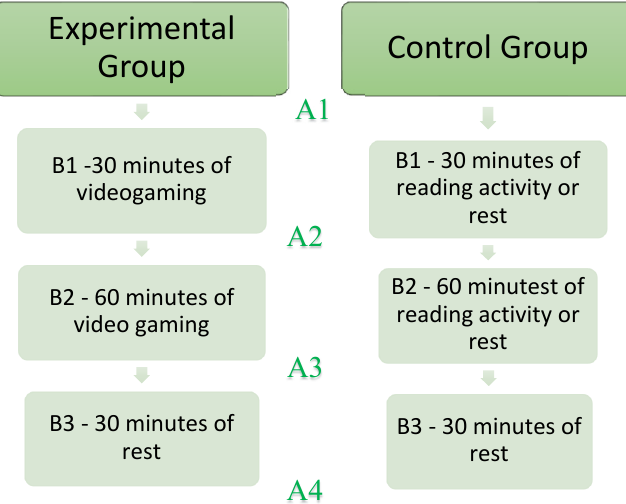
Figure 1. Research plane. Each A refers to each of the four measurement phases, each B refers to the intervention phases.